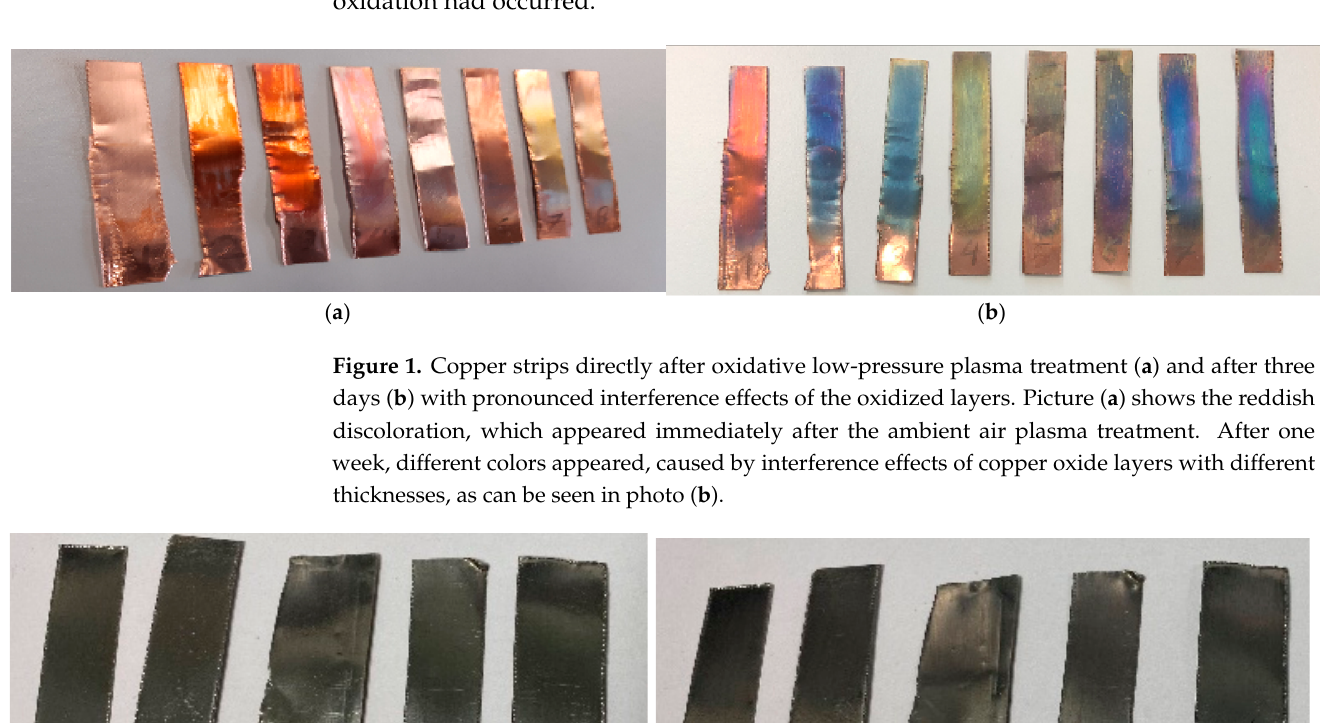
Figure 3. Redox equations of metal oxidation based on the experimental results. The fi rst equation describes a plasma-induced dissociation of molecular oxygen to excited oxygen atoms (O*). The two equations below show the speci fi c oxidation and reduction processes. The metal strips were analyzed via XPS after the ambient air plasma treatment on their atomic composition. These results are shown in Table 2. Table 2. Composition of the metal strips before and after low-pressure plasma treatment with am- bient air for 60 min. These data were obtained from XPS measurements. Sample